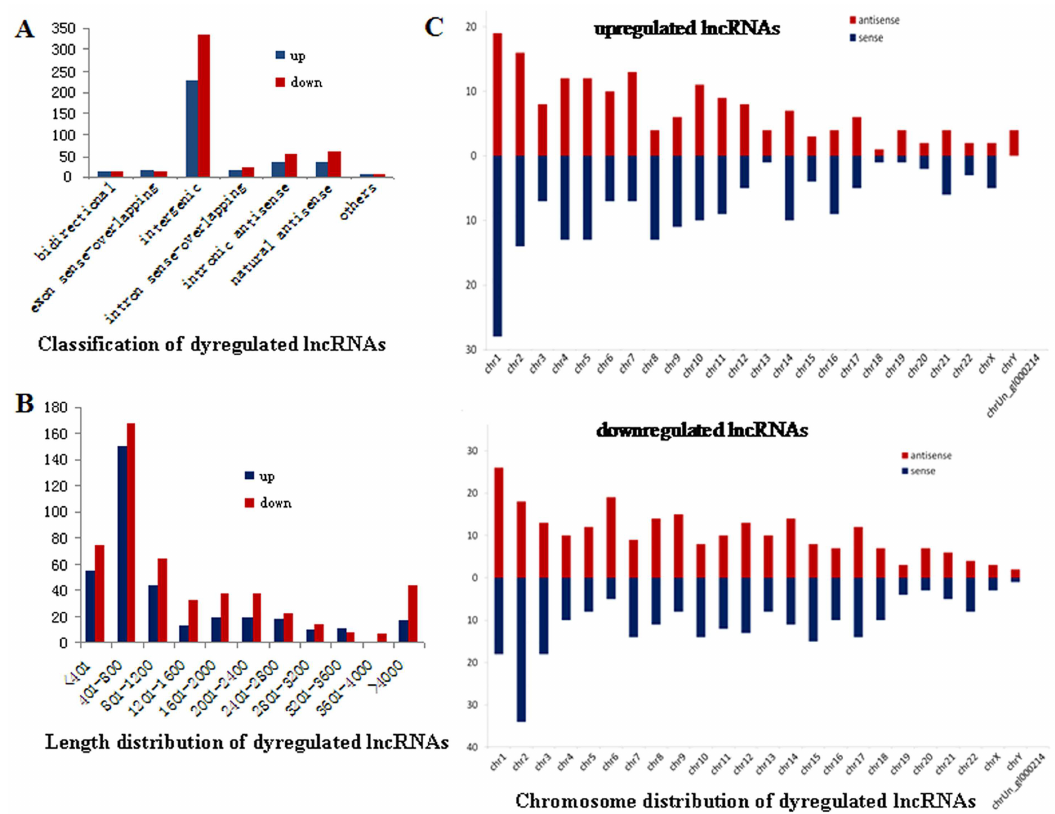
Fig 2. Expression signatures of deregulated lncRNAs in ATB group versus control group. (A) Classification of lncRNAs. They were mainly intergenic.(B) Length distribution of lncRNAs. They were mainly between401 and 800 nt in length. (C) Chromosome distributionof lncRNAs. Chromosome 1 and 2 were the most frequent ones and numbersof the deregulatedlncRNAs on the two chromosomes accountedfor approximately 11% and 9% of total deregulatedones, which were higherthan the expectednumbers based on chromosome total lncRNAnumbers,